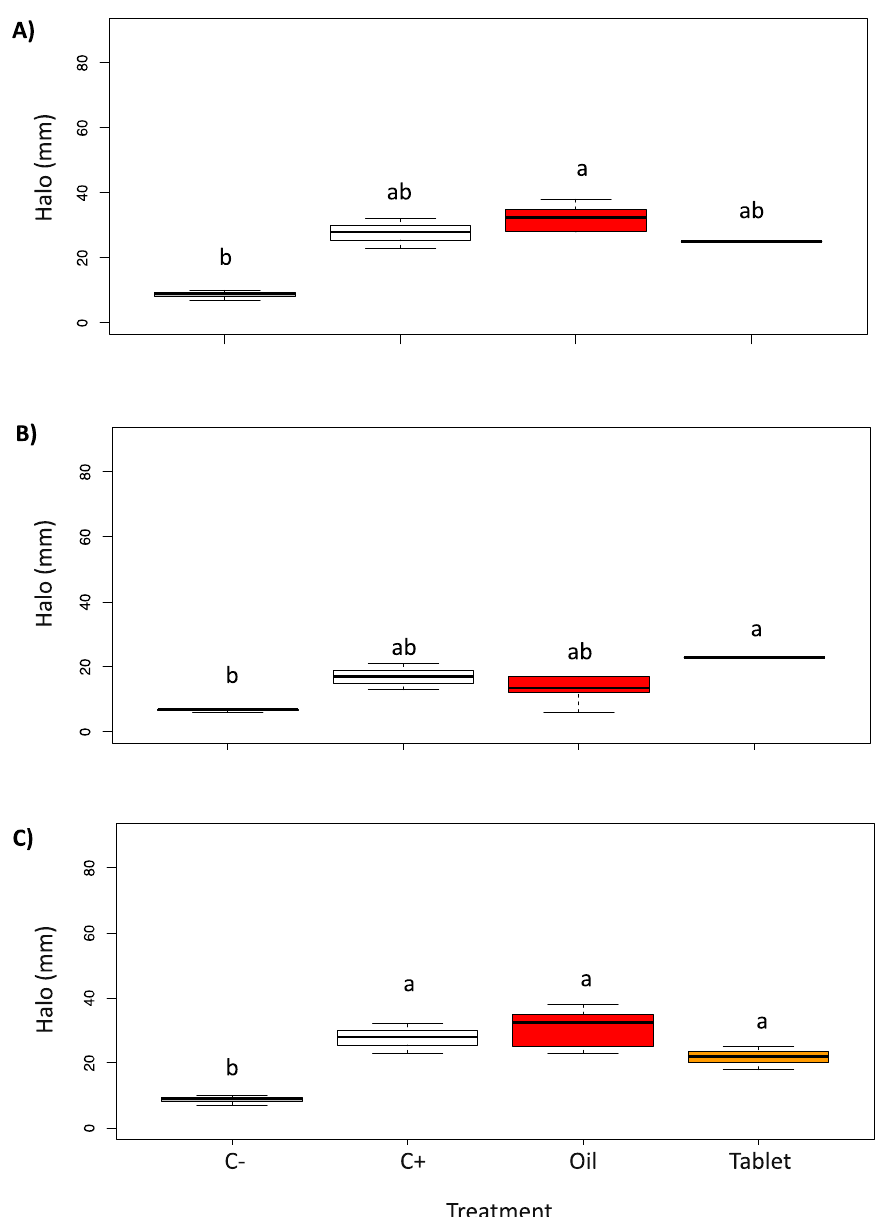
Figure 7. Boxplots of the growth inhibition halo (mm) induced by T. vulgaris on S. aureus ( A ), P. aeruginosa ( B ), and K. pneumoniae ( C ). C − = negative control (1,4-dioxane); C+ = positive control (gentamycin, meropenem, meropenem, respectively); Oil = T. vulgaris essential oil; Tablet was produced adding Thymus vulgaris essential oil with cyclodextrin-powder. Different letters in the figure indicate significant differences between treatments at p < 0.05.